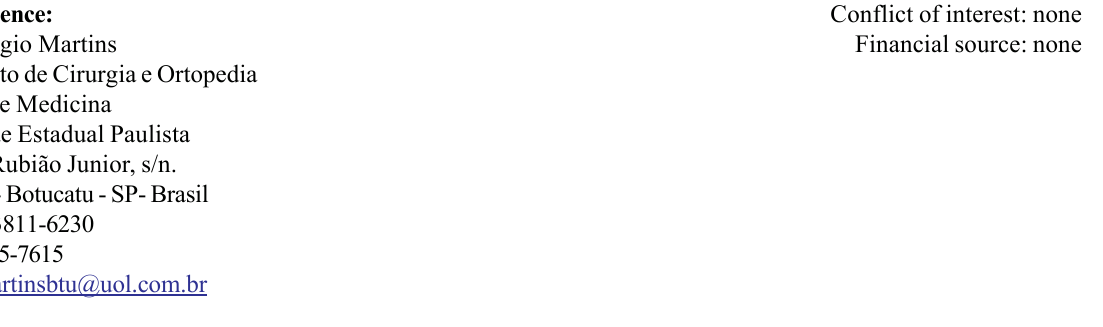
*Color figure available from